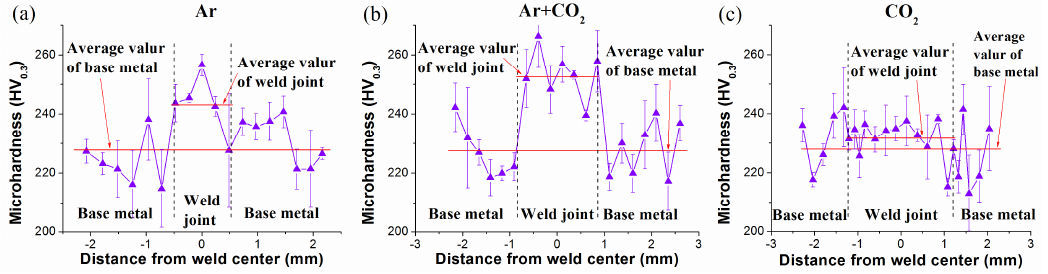
Figure 9. Microhardness of weld joints under different shielding gas conditions: ( a ) in Ar; ( b ) in Ar + CO 2 ; ( c ) in CO 2 .